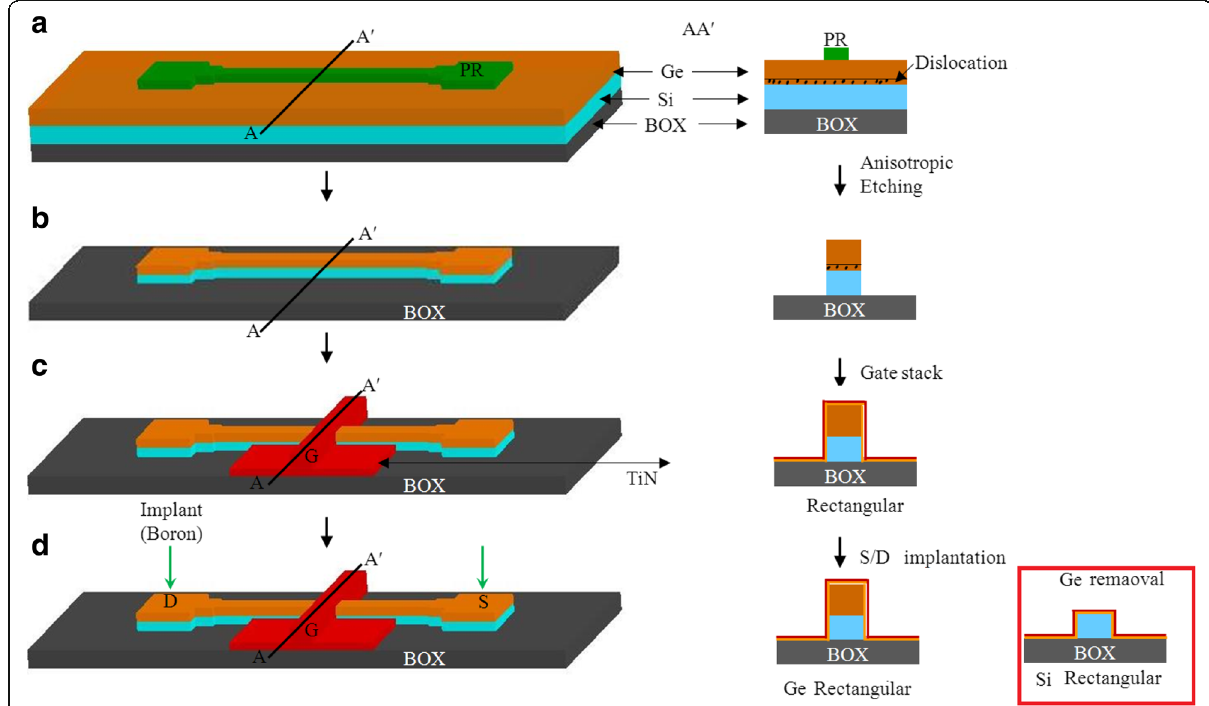
Fig. 8 Schematic of the device fabrication. a Fin patterning. The starting materials is Ge (130 nm) on BOX. b Anisotropic etching and photoresist striping. c Gate formation by atomic layer deposition of ZrO 2 and TiN deposition. d Self-aligned boron implantation on S/D for good contact. Note: the left side is the 3D schematics and the right side is the corresponding cross sectional view